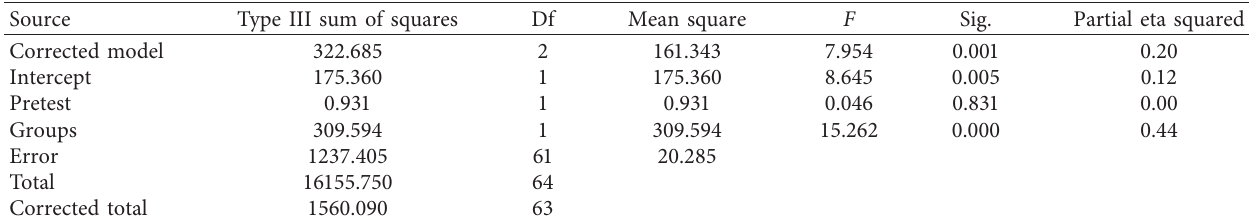
Table 5: Results of one-way ANCOVA for comparing the posttest scores of the EG2 and CG learners.